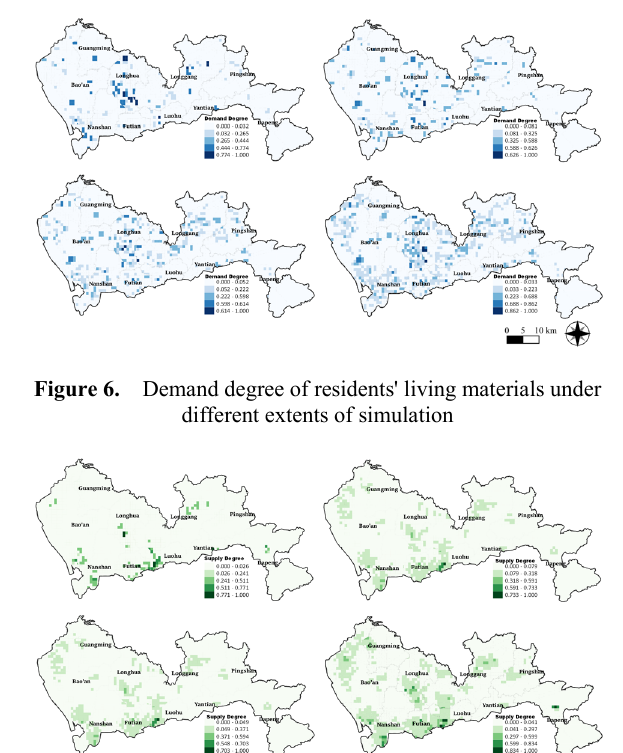
Figure 5. Simulation results of infectious diseases